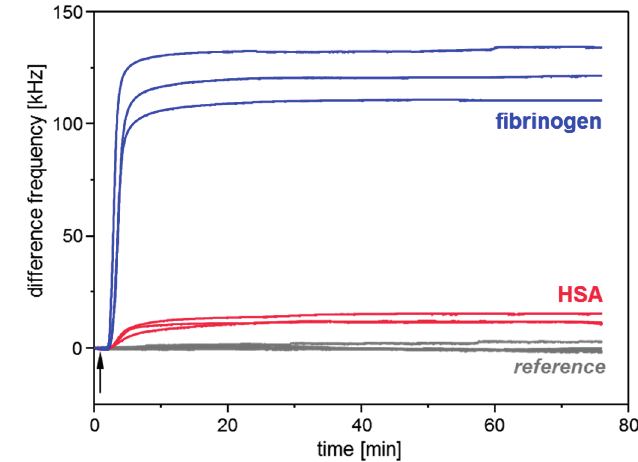
Figure 6. Conditioning film monitoring with SAW resonators coated with parylene C: Adsorption of plasma proteins HSA (red curves) and fibrinogen (blue curves). Samples contained 250 µg/mL protein in PBS and were injected into a PBS carrier stream. Injection started 1 min after start of the measurement (see arrow). Gray curves represent the signals obtained with the reference resonators, which were rinsed with carrier medium PBS throughout the complete measurement.